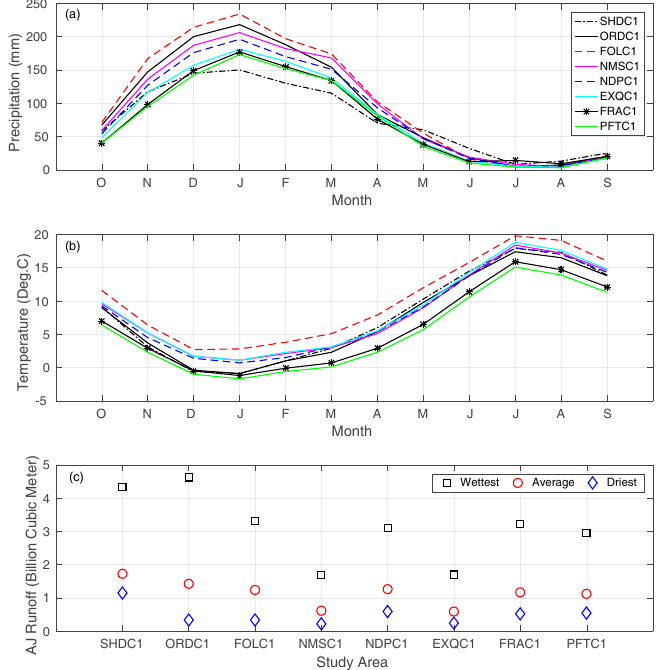
Figure 2. ( a ) Mean monthly precipitation and ( b ) mean monthly temperature of the study areas for October (O), November (N), December (D), January (J), February (F), March (M), April (A), May (M), June (J), July (J), August (A), and September (S). Period of record is from water year 1949 to 2010; ( c ) April–July streamflow runoff volume (in billion m 3 ) in the wettest, average, and driest years in the study period (1985–2010) for the study areas.